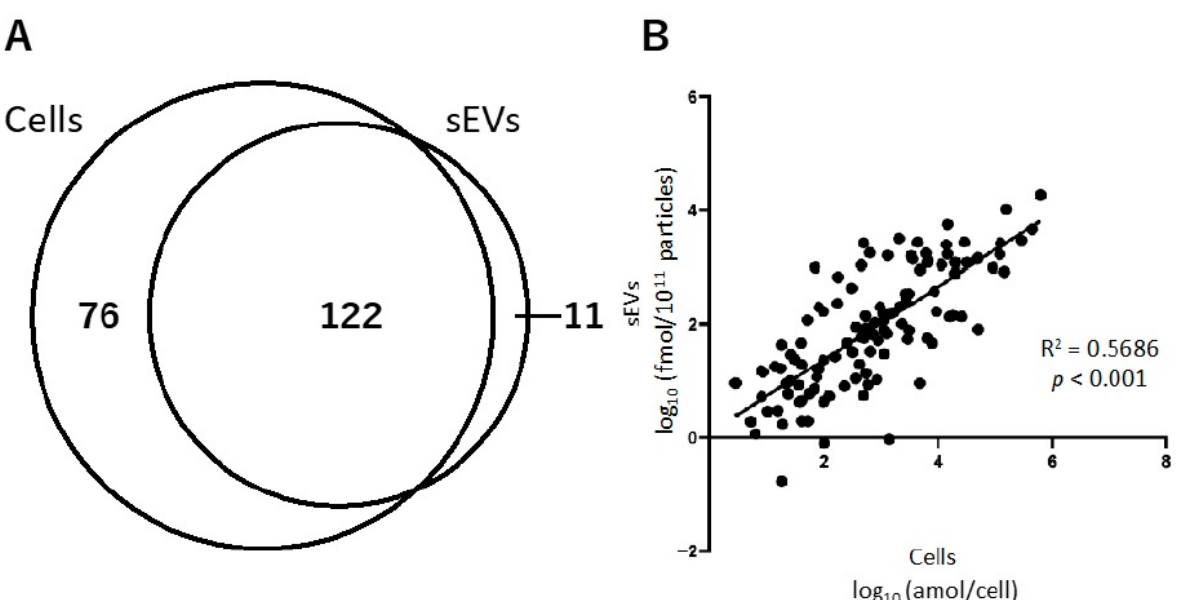
Figure 2. The relationship of hydrophilic metabolites present in cells and small extracellular vesicles (sEVs) obtained under normoxia. ( A ) Venn-diagram representing the number of hydrophilic metabolites detected in cell and sEV samples. ( B ) Correlation of the hydrophilic metabolites present in cells and sEVs.